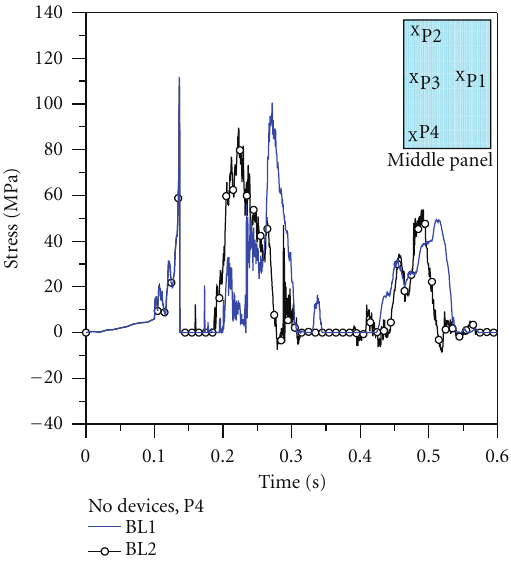
Figure 8: Comparison of maximum tensile stresses at location P4, as a function of time (ABAQUS). No devices. M01 FE-model, BL1 and